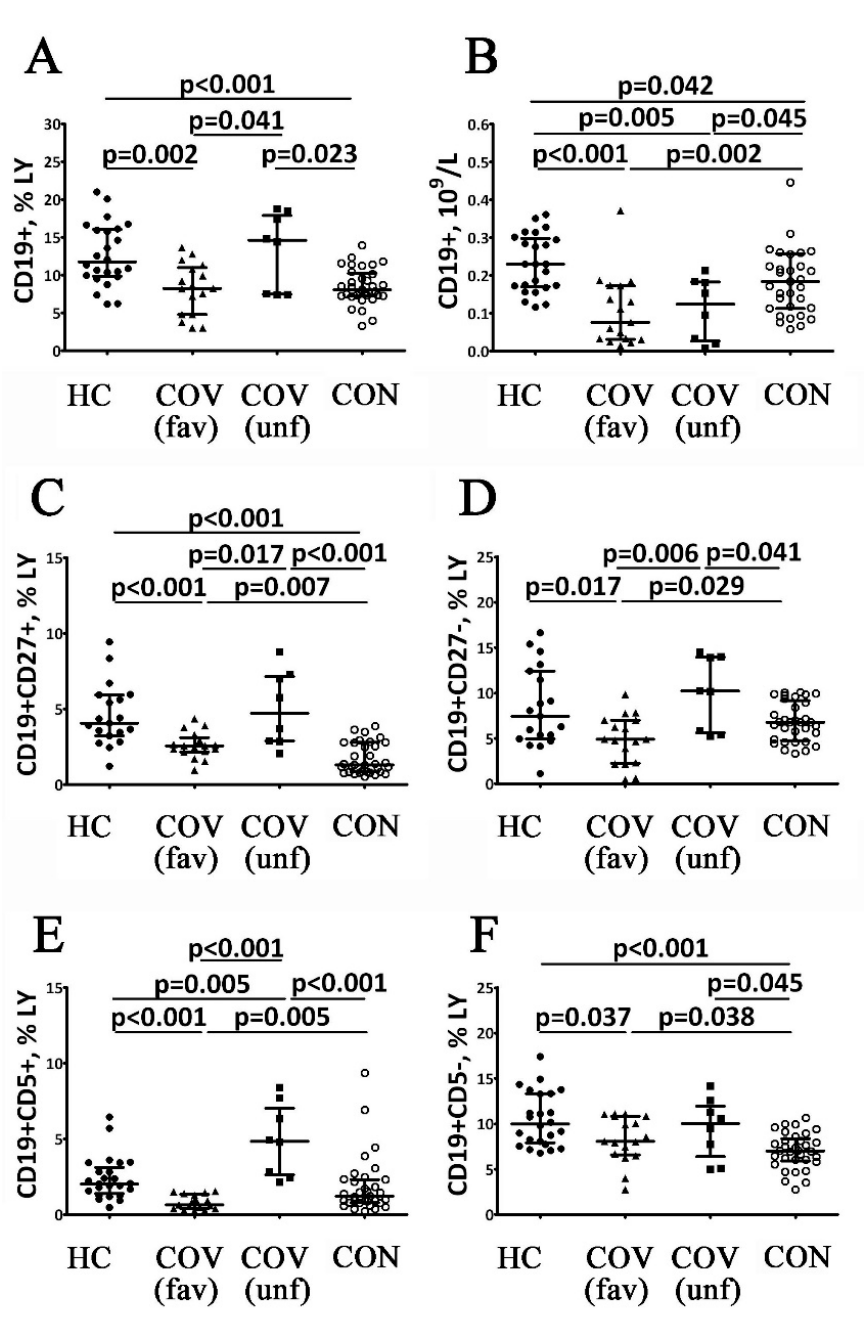
Figure 4. Alterations in B cell subsets in patients with acute COVID-19 and COVID-19 convalescent patients. Scatter plots ( A , B ) show the percentages (the percentage of B cells within total lymphocyte population) and absolute numbers (number of B cells in 1 L of peripheral blood, 10 9 /L) of B lympho- cytes (CD19+), respectively. Scatter plots ( C , D ) show the percentages (the percentage of B cell sub- sets within the total lymphocyte population) of CD27-positive and CD27-negative B cells, respec- tively. Scatter plots ( E , F ) show the percentages (the percentage of B cell subsets within total lym- phocyte population) of CD5-positive and CD5-negative B cells, respectively. Black circles—healthy control (HC, n = 24); black triangles—patients with acute COVID-19 (COV (fav), favorable outcome, n = 25); black squares—patients with acute COVID-19 (COV (unf), unfavorable outcome, n = 8); and white circles—COVID-19 survivors (CON, convalescent patients with favorable outcome of acute COVID-19, n = 33). Each dot represents individual subjects, and horizontal bars depict the group medians and quartile ranges (Med (Q25; Q75). Statistical analysis was performed with the Mann– Whitney U test.